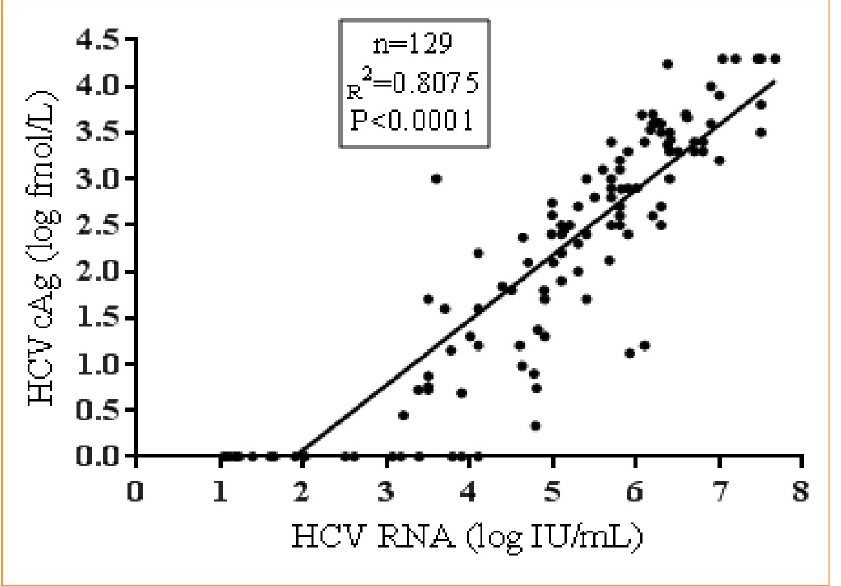
Fig 4. Correlation between HCV RNA and HCVcAg in HCV RNA positive